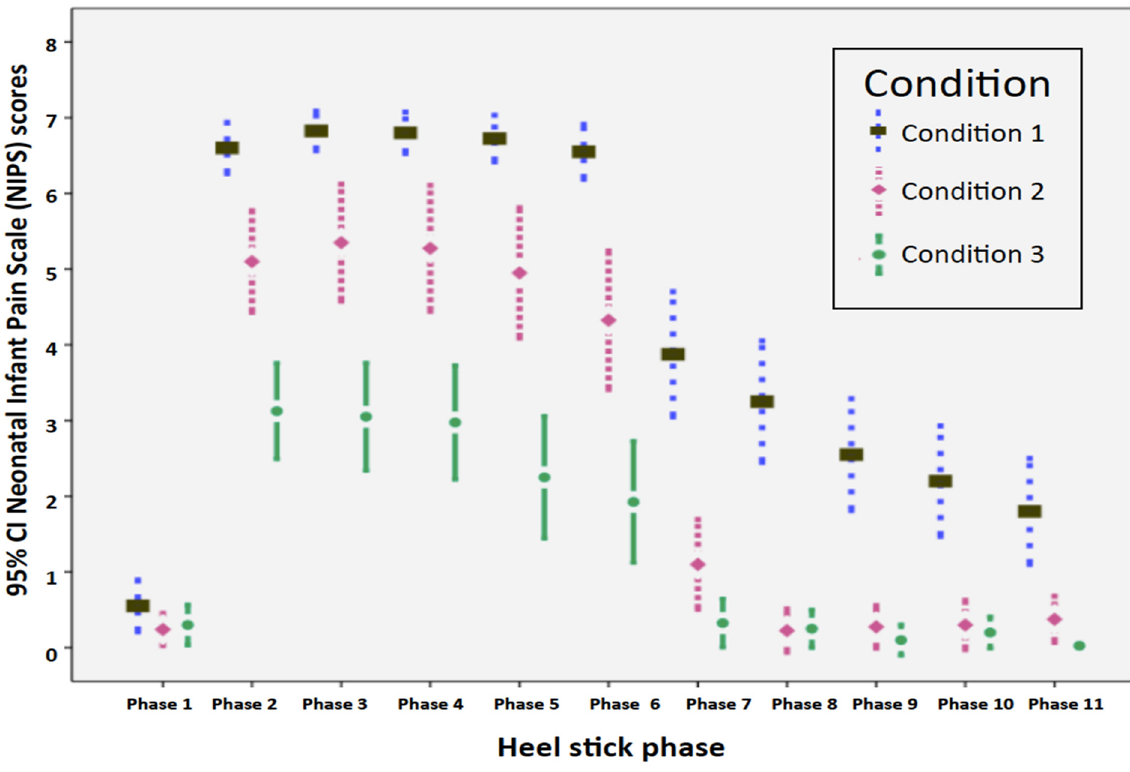
Figure 1. Clustered error-bar graphs. Time trends in Neonatal Infant Pain Scale (NIPS) scores of full-term infants in the three treatment conditions over 11 heel stick phases; Condition 1 (square): GT + VC; Condition 2 (diamond): Breastmilk-odor + GT+ VC; Condition 3 (circle): breastmilk-odor + breastmilk-taste + GT + VC.